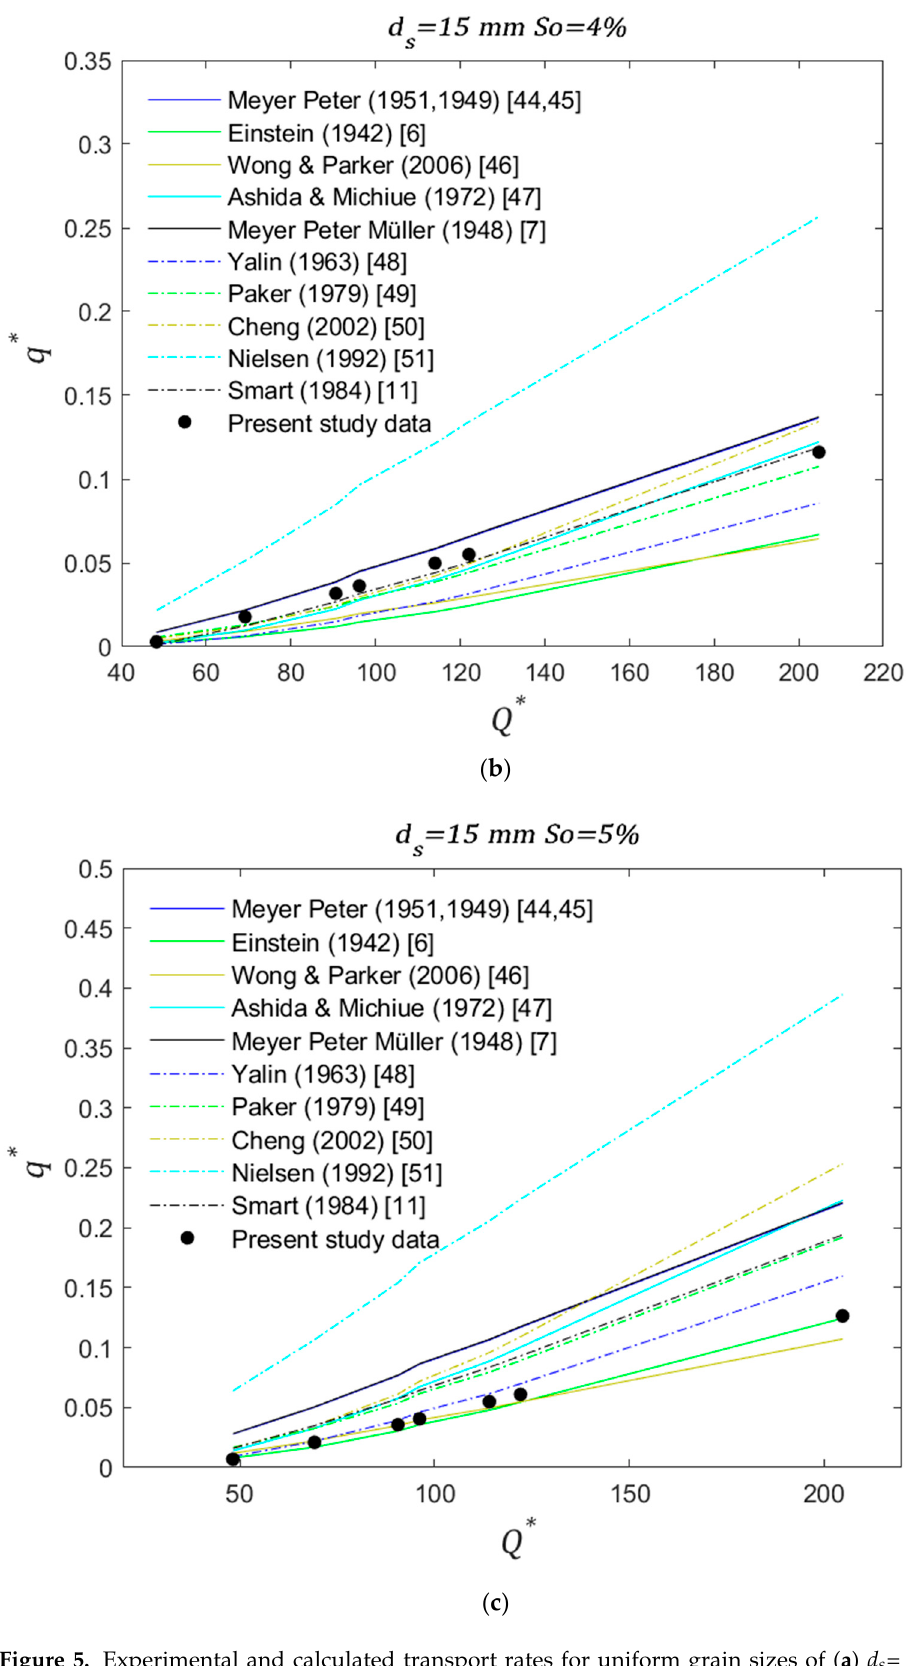
Figure 5. Experimental and calculated transport rates for uniform grain sizes of ( a ) d s =15 mm So =3%, ( b ) d s =15 mm So =4%, and ( c ) d s =15 mm So =5%.